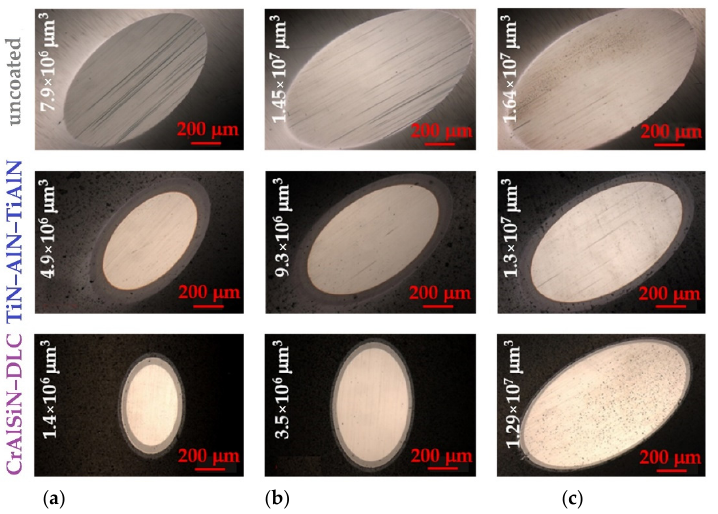
Figure 6. The type of wear holes and the volume of the worn surface versus the time of the abrasion test for ball end mills with different coatings: ( a ) at 5 min; ( b ) at 10 min; ( c ) at 15